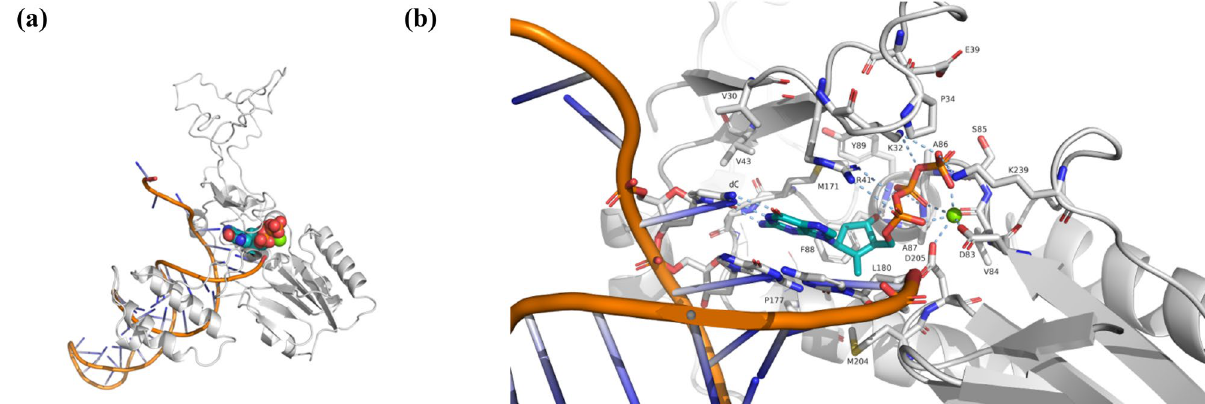
Figure 7. Model of HBV RT (genotype A) based on the HIV RT-DNA-entecavir complex X-ray crystal structure, PDB ID 5XN1 43 . ( a ) Entecavir-triphosphate is shown as spheres with teal-colored carbon atoms, red oxygen, blue nitrogen, and orange phosphorus atoms. Entecavir is at the 3 ′ end of the DNA strand (orange cylinders). The secondary structure of the HBV RT model is shown as white coils ( α -helices), white arrows ( β -strands), and white loops. ( b ) Close-up view of the binding pocket, showing entecavir-triphosphate with teal-colored carbons, and a Mg 2+ cation as a green sphere. Note that hydrogen bonds and metal bonds are shown as light blue dashed lines. The deoxyguanine (dG)-moiety of entecavir can be seen “base-pairing” with deoxycytosine (dC) in a second strand of